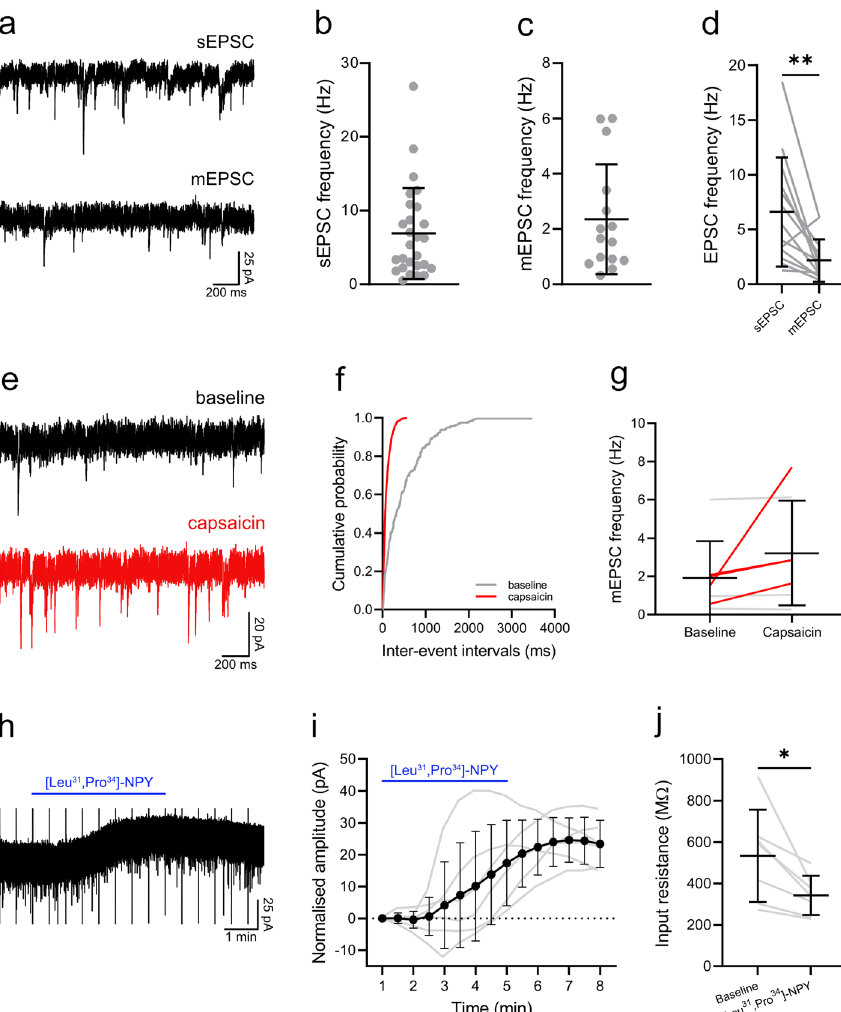
Figure 10. Excitatory synaptic input to NPFF cells and responses to capsaicin and the neuropeptide Y1 receptor agonist, [Leu 32 ,Pro 34 ]-NPY. ( a ) Example traces of spontaneous (top) and miniature (bottom) EPSCs recorded in the same NPFF cell. The frequency of the sEPSCs was 6.9 ± 6.1 Hz, n = 27 ( b ) and the frequency of the mEPSCs was 2.3 ± 2.0 Hz, n = 15 ( c ). ( d ) In those cells where both sEPSCs and mEPSCs were recorded, the sEPSC frequency was significantly greater 6.6 ± 5.0 vs. 2.2 ± 1.9 Hz; P = 0.003, paired t test, n = 13. The functional expression of TRPV1 channels on primary afferent input to NPFF cells was assessed by recording mEPSCs in response to the application of the TRPV1 agonist, capsaicin. ( e ) Representative traces of mEPSCs recorded before (baseline: top) and during application of capsaicin (bottom). ( f ) Example cumulative probability plot demonstrates a significant leftward shift in the distribution of interevent intervals in response to capsaicin ( P < 0.00001, Kolmogorov–Smirnov 2-sample test). A significant leftward shift in mEPSC interevent intervals, signifying an increase in mEPSC frequency, was seen in 4 of 7 cells treated with capsaicin ( g ). In those cells that responded to capsaicin, the mEPSC frequency was increased from 1.5 ± 0.7 to 3.8 ± 2.7 Hz, n = 4 (red lines), while in the remaining 3 cells (grey lines) mEPSC frequency was 2.4 ± 3.1 and 2.5 ± 3.2 Hz prior to and during capsaicin application, respectively. Responses of NPFF neurons to the neuropeptide Y1 receptor agonist, [Leu 32 ,Pro 34 ]-NPY, were assessed and an example trace is shown in ( h ). ( i ) All six NPFF cells tested displayed a clear outwards current in response to [Leu 32 ,Pro 34 ]-NPY, which also resulted in a significant reduction in input resistance from 533.5 ± 223.5 to 342.3 ± 95.0 MΩ, P = 0.016, Wilcoxon matched-pairs signed rank test ( j